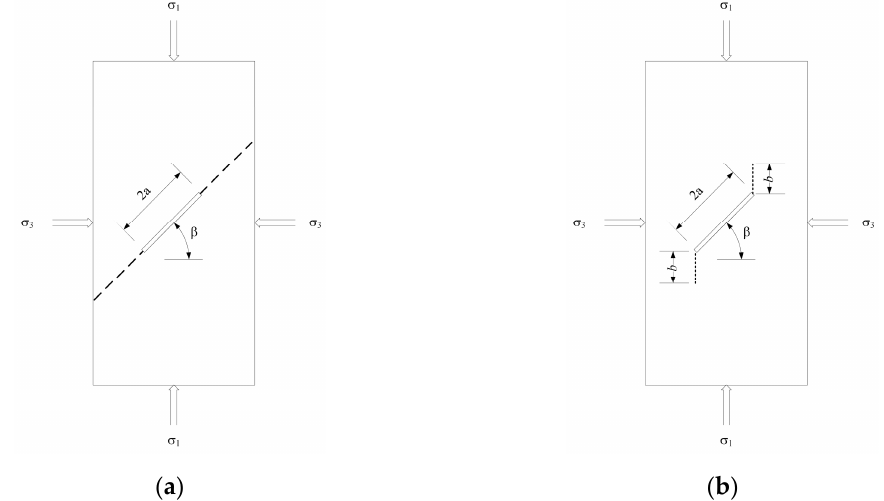
Figure 13. Schematic illustration of the crack model ( a ) shear crack mode; ( b ) sliding crack